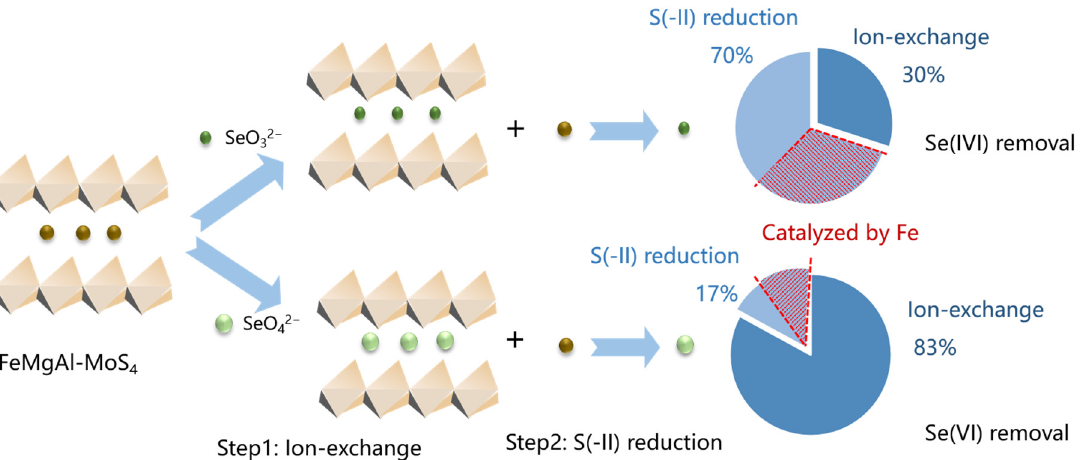
Figure 5. Sorption processes and Fe roles towards selenite and selenate removal by FeMgAl − MoS 4